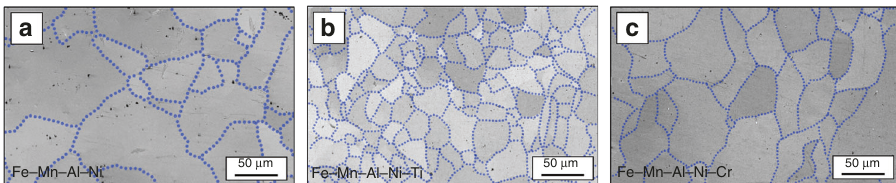
Fig. 6 Subgrain structures characteristic for the Fe – Mn – Al – Ni – X (X = Ti, Cr) shape memory alloys. Electron-backscatter diffraction image quality maps of Fe – Mn – Al – Ni ( a ), Fe – Mn – Al – Ni – Ti ( b ), and Fe – Mn – Al – Ni – Cr ( c ). Blue dotted lines point out the low-angle grain boundaries of the subgrains. Details on the heat treatment are shown in Supplementary Figure 1c